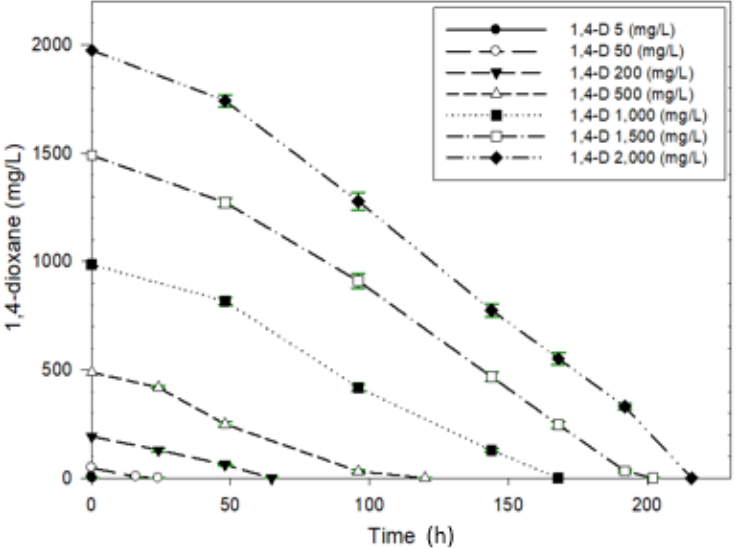
Figure 4. Degradation of 1,4-dioxane (1,4-D) at various initial concentrations.